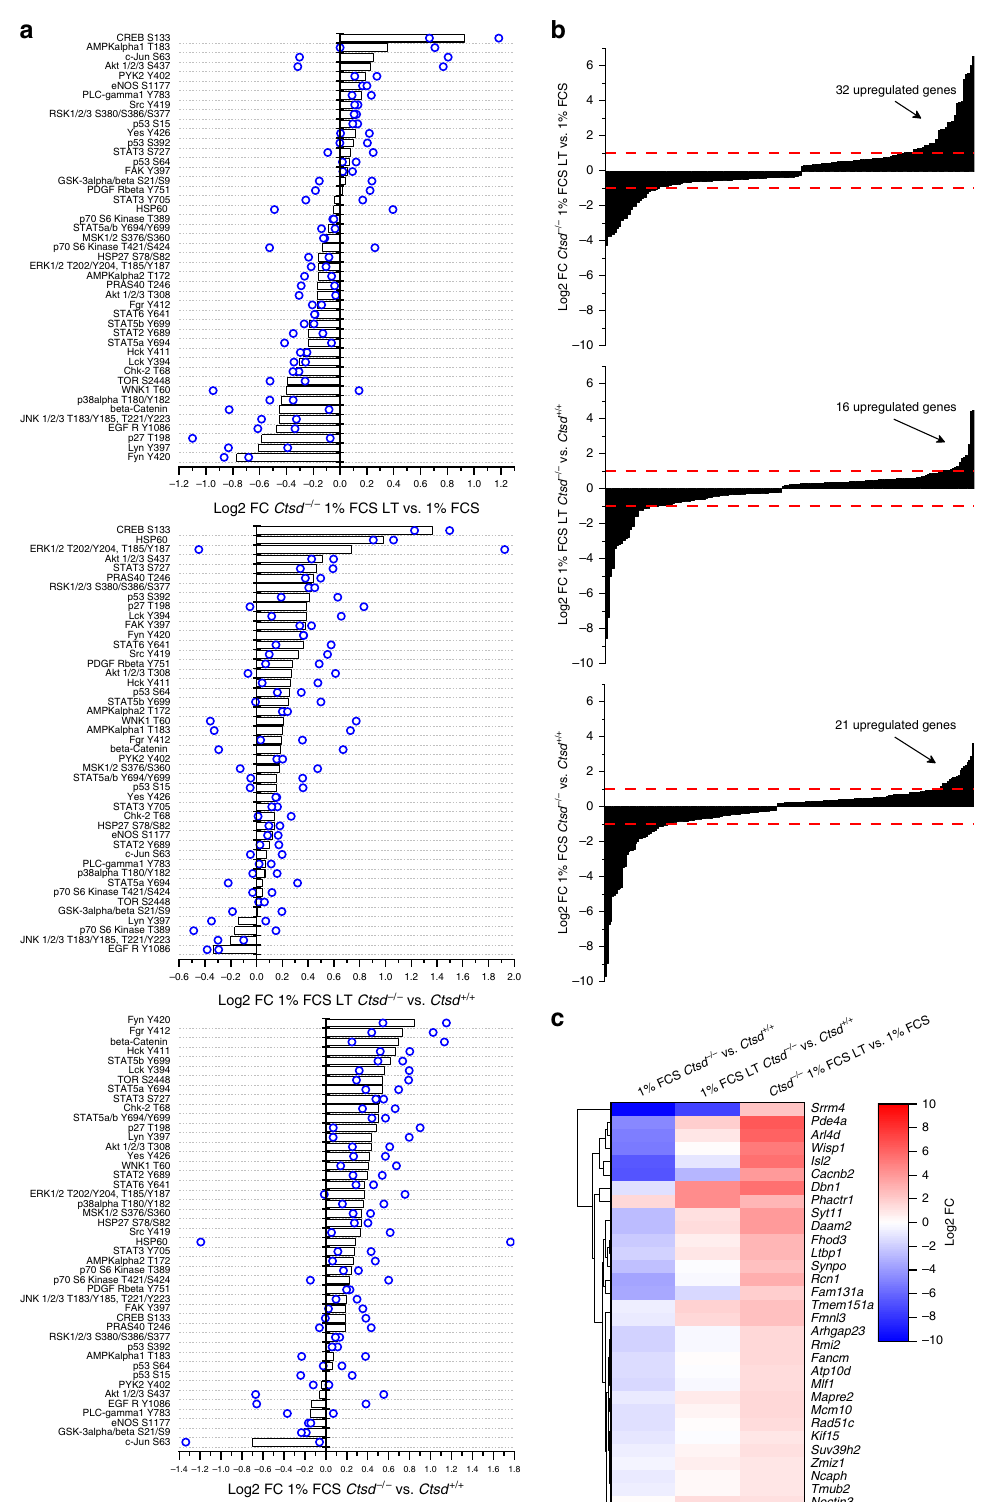
Fig. 8 CTSD-de fi cient tumor cells having escaped quiescence activate tumorigenic CREB. a Phospho-kinase antibody arrays with lysates from Ctsd + / + and Ctsd − / − PyMT cells cultured for 7 – 10 days (1% FCS) or for ≥ 8 weeks (1% FCS LT) in 1% FCS medium. Changes in phosphorylation are plotted as log2 fold change (FC) for indicated comparisons ( n = 2 independent experiments). b , c Transcriptome analysis of 1% FCS and 1% FCS LT Ctsd + / + and Ctsd − / − PyMT cells ( n = 3 independent experiments). b Change in expression of signi fi cantly regulated genes of the CREB gene set for indicated comparisons. Red dashed lines, borders for gene up- and downregulation (|log2 FC | > 1). c Clustering analysis of the log2 FC of CREB genes with signi fi cant upregulation in Ctsd − / − 1% FCS LT versus 1% FCS PyMT cells for indicated comparisons shown as heatmap. Source data are provided as a Source Data fi